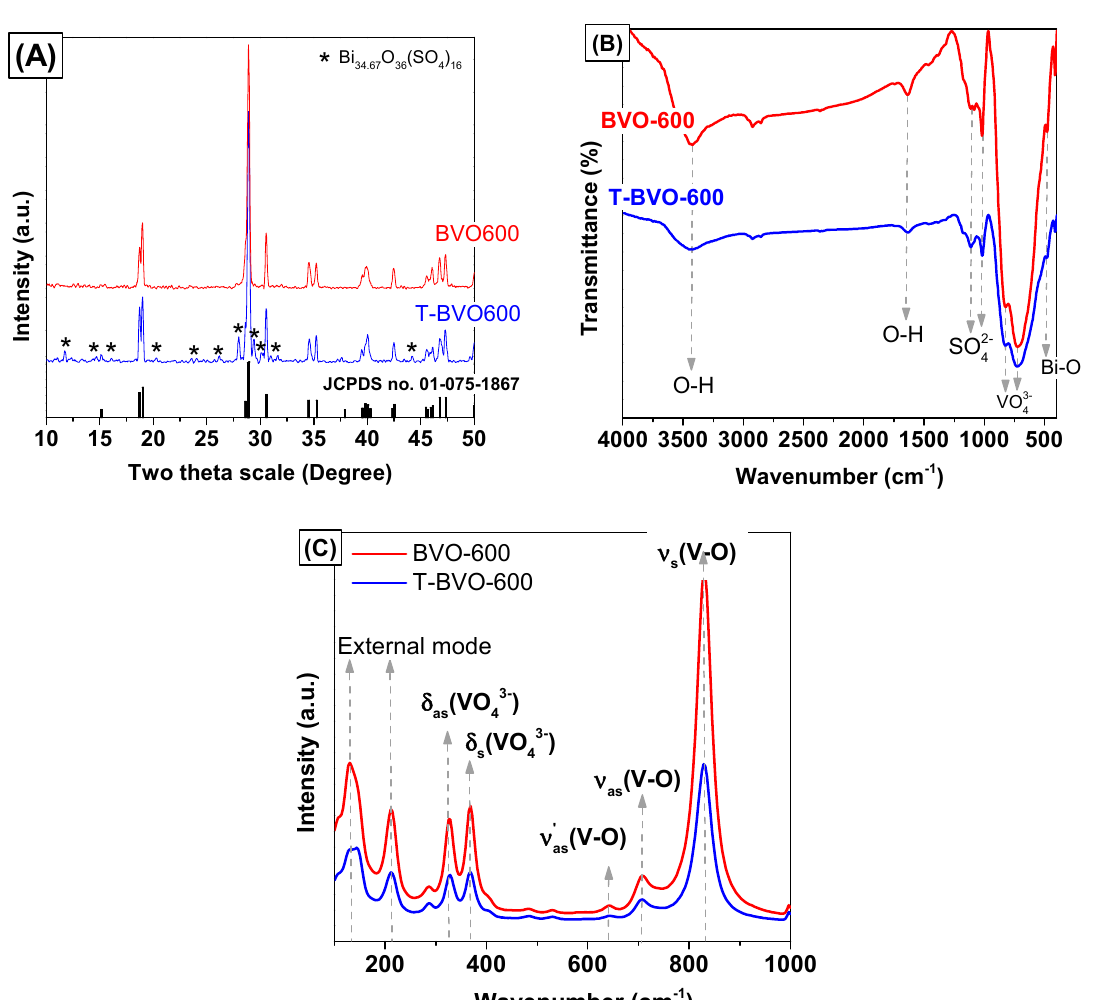
Figure 1. The X-ray diffraction (XRD) patterns ( A ), Fourier transform infrared (FT-IR) spectra ( B ), and Raman spectra ( C ) of T-BVO-600 and BVO-600.